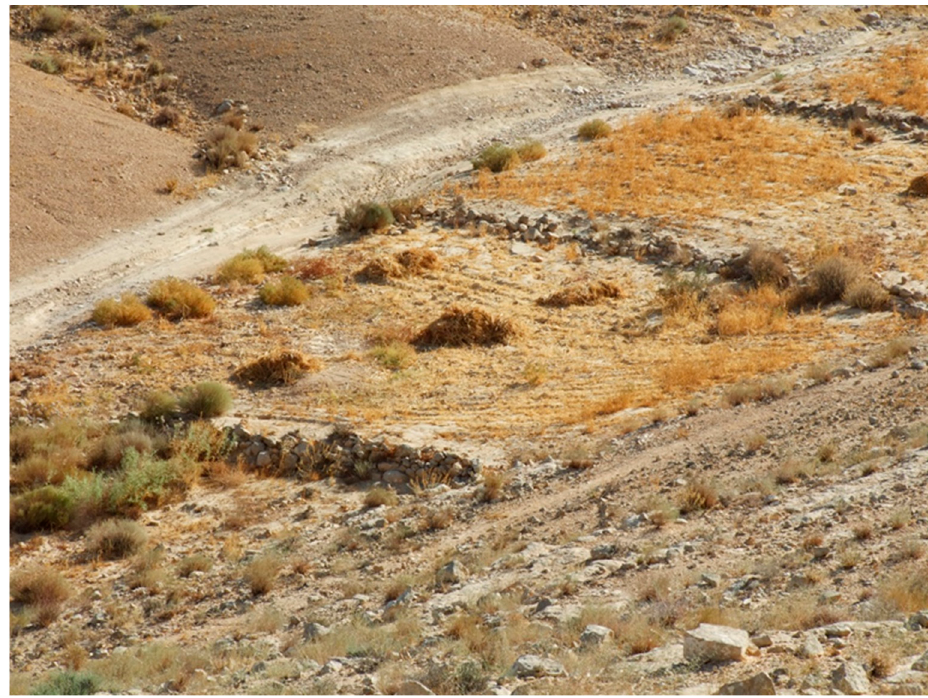
Figure 7. Shallow agricultural Type A terraces of in the Negev Highlands designated for the culti- vation of cereals. (Photograph: Y. Avni).